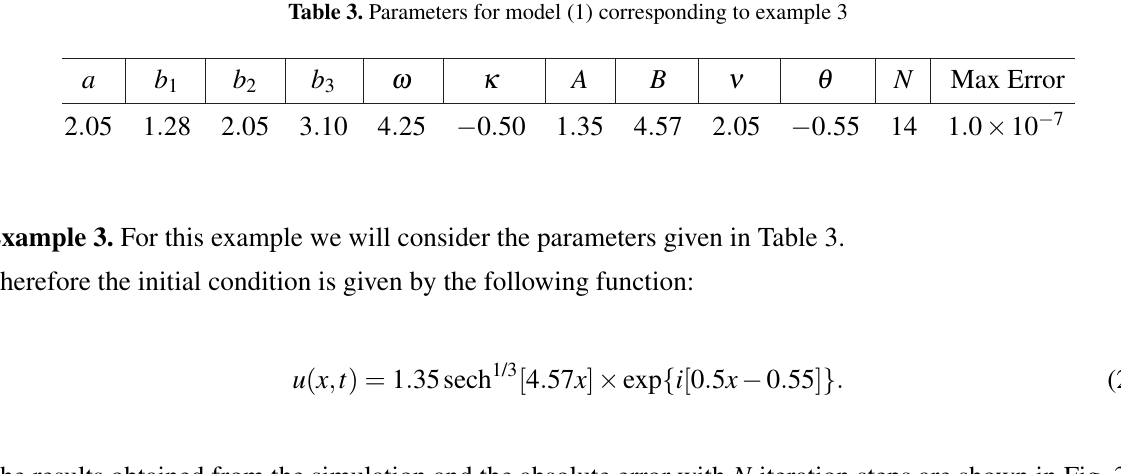
Table 3. Parameters for model (1) corresponding to example 3